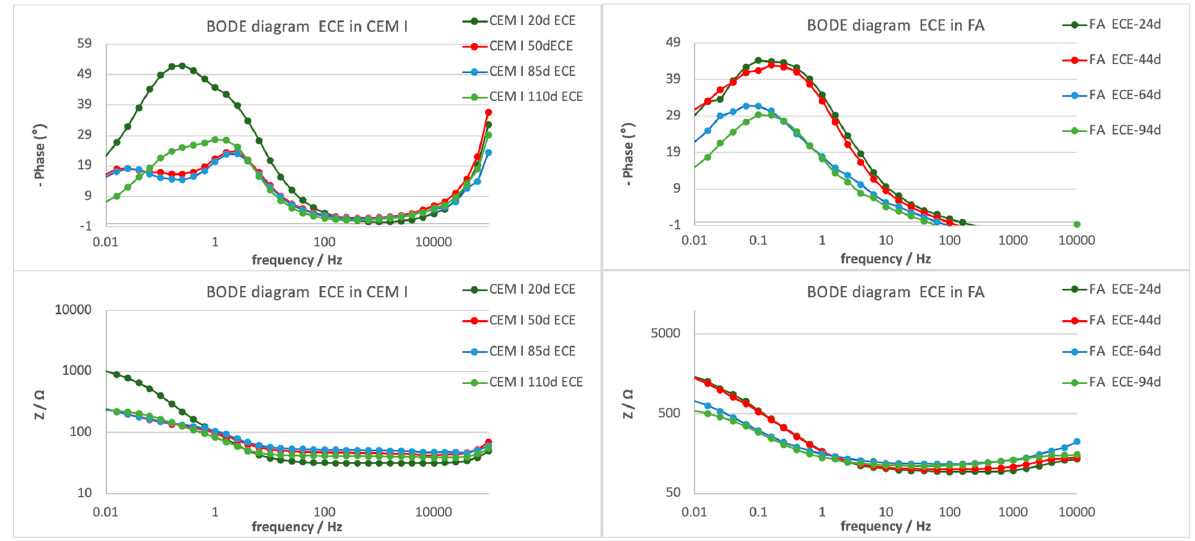
Figure 9. Bode diagrams showing the ECE treatment evolution in the different mortar typologies. Table 7. Characteristic parameters obtained from the fitting of the Nyquist semicircle obtained by the EIS during the ECE treatment.